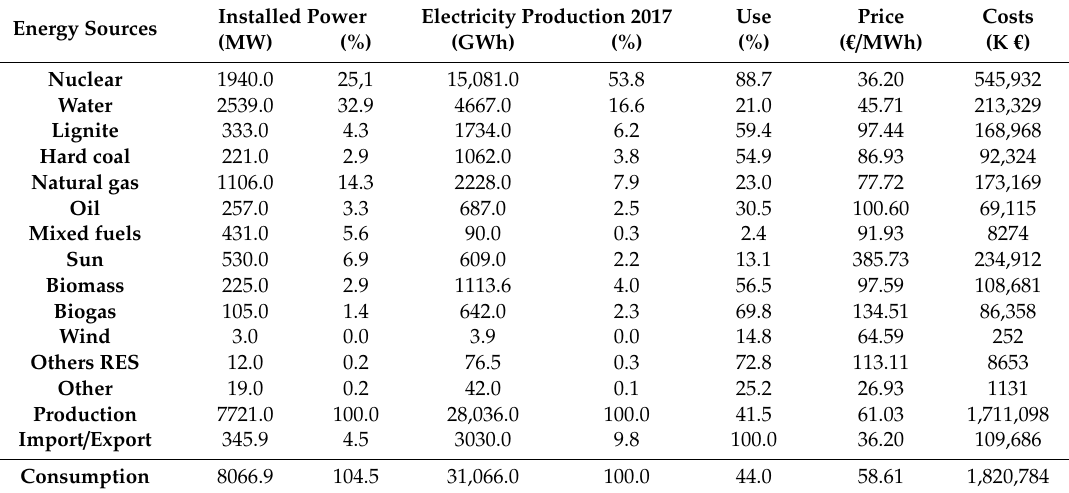
Table 1. Production and consumption of electricity in Slovakia in 2017 (Source: